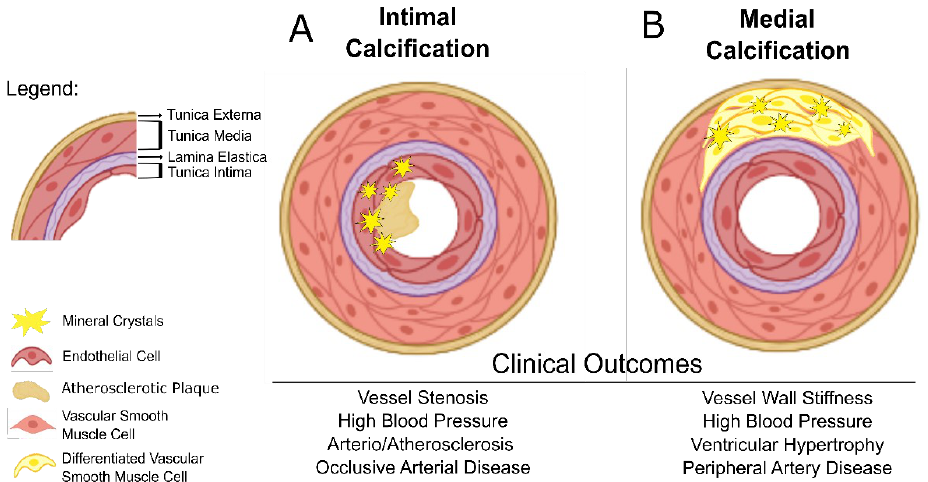
Figure 1. Intimal and Medial Calcification. ( A ) Intimal calcification is confined to the lumen or endothelium of the vessel mainly associated with atherosclerosis, contributing to vessel stenosis, lumen narrowing and increased blood pressure. ( B ) Medial calcification affects the medial layer of the vessel wall mainly composed of vascular smooth muscle cells, leading to increased vessel wall stiffness with compromised blood pumping and compliance, reflecting in high blood pressure, peripheral artery disease or even ventricular hypertrophy.